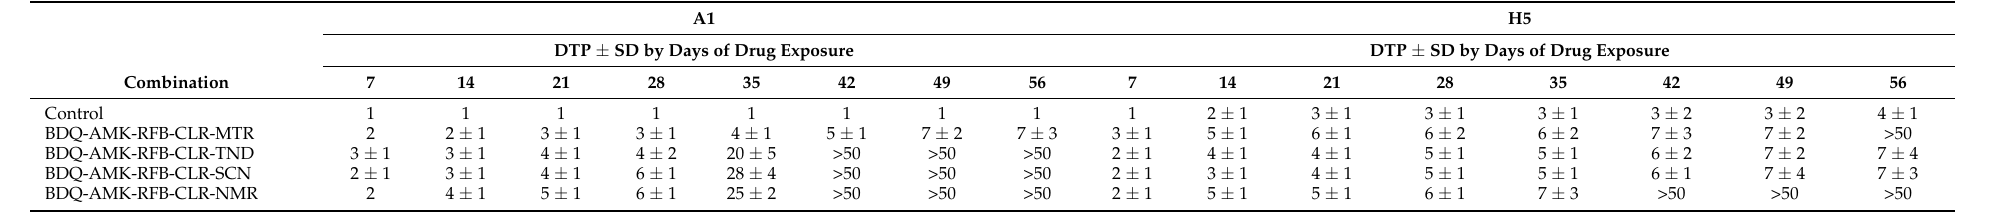
Table 1. Survival of A1 and H5 cells to various drug combinations, as estimated by regrowth in liquid medium using the MGIT 960 system. Day-to-positivity (DTP) values are indicated. Samples inoculated in MGIT 960 tubes refer to samples of Figure 8.